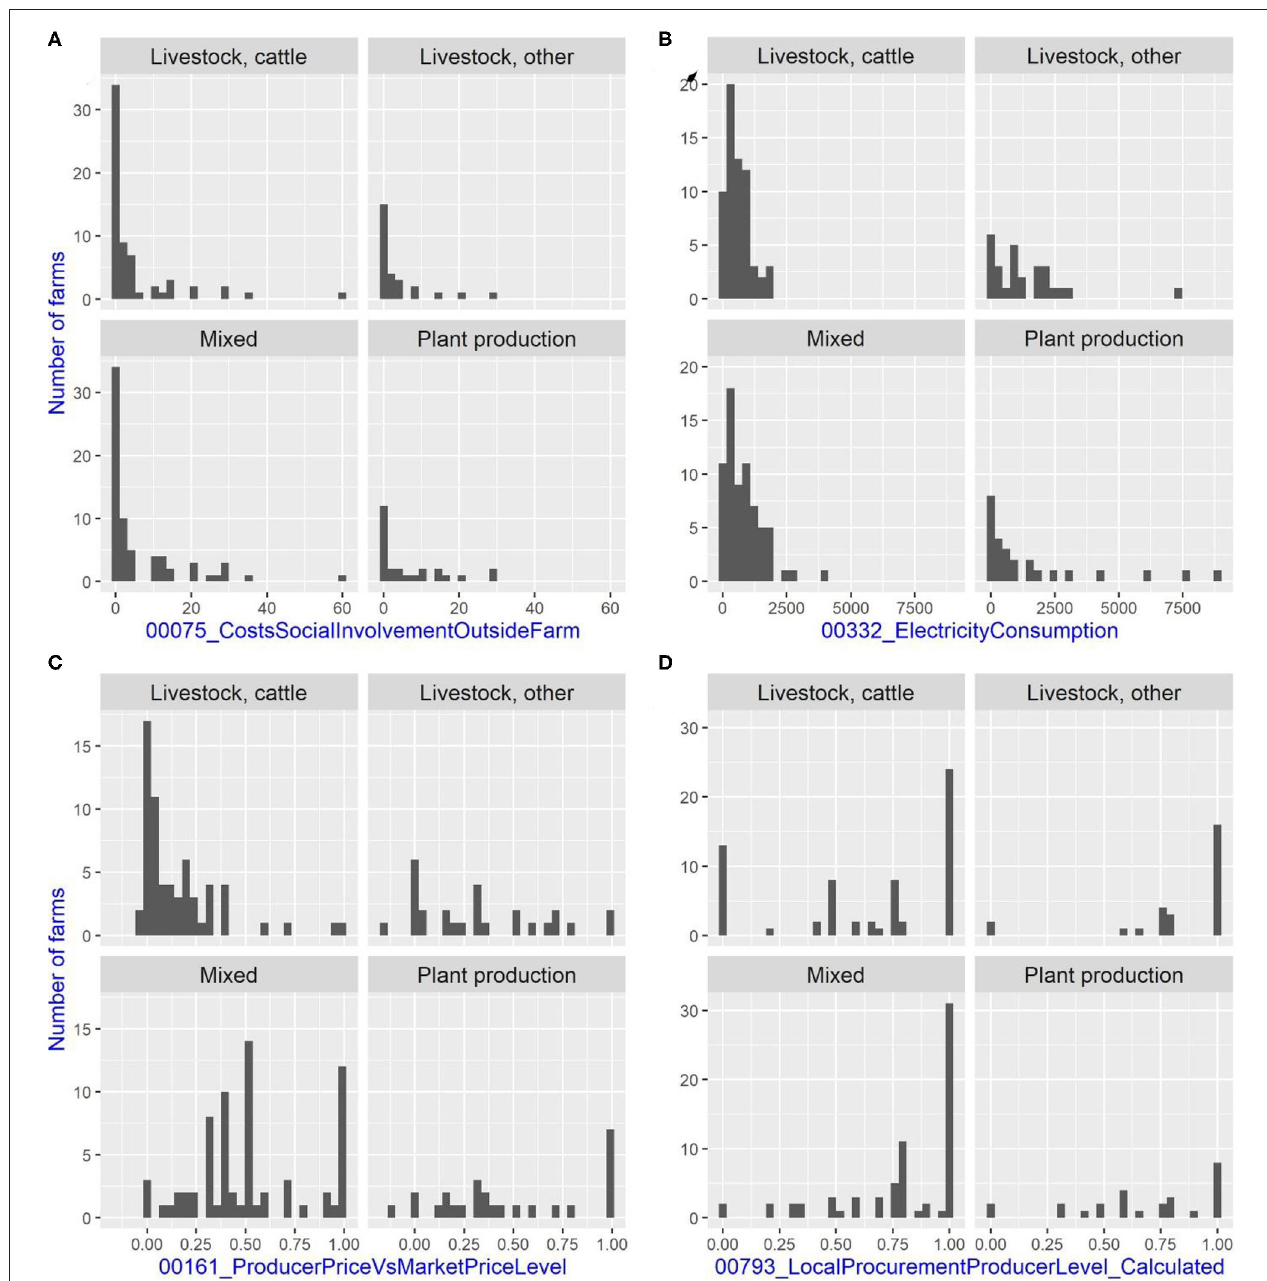
FIGURE 6 | Unrated raw responses for four prominent numerical indicators from the final set, plotted by farm type and agricultural zone. Indicators are 00075: Social Involvement Outside of the Farm (A) , 00332: Electricity Consumption (B) , 00161: Price Premium (C) and 00793: Procurement of Locally Produced Inputs (D)